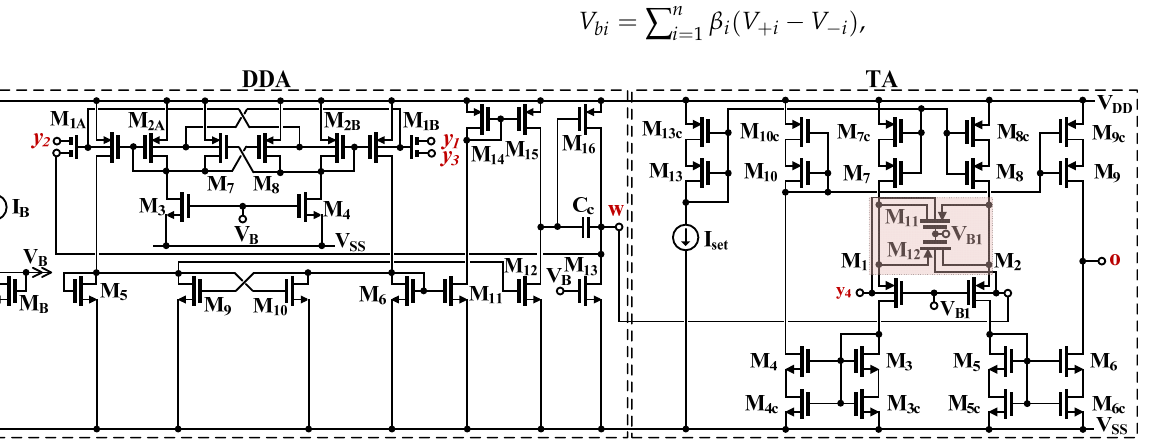
Figure 2. The CMOS structure of the 0.5 V DDTA.